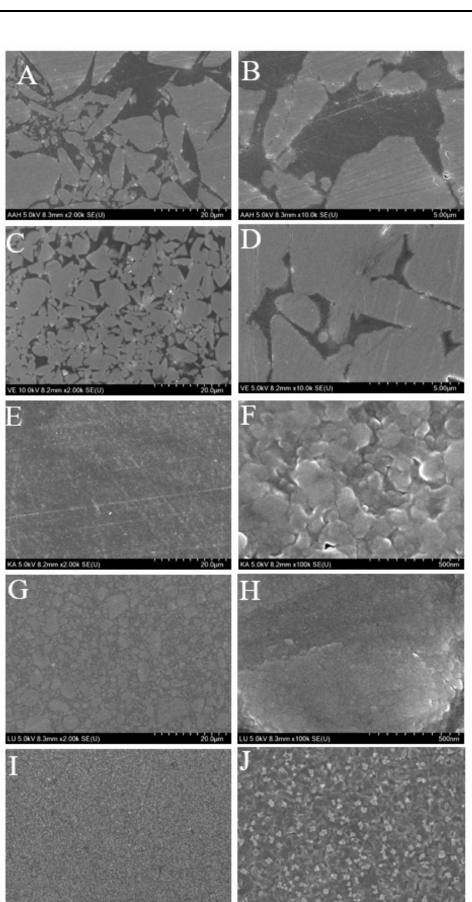
Figure 6. SEM images of the five tested materials before toothbrushing: ( A , B ): AH; ( C , D ): VE; ( E , F ): KA; ( G , H ): LU; ( I , J ):